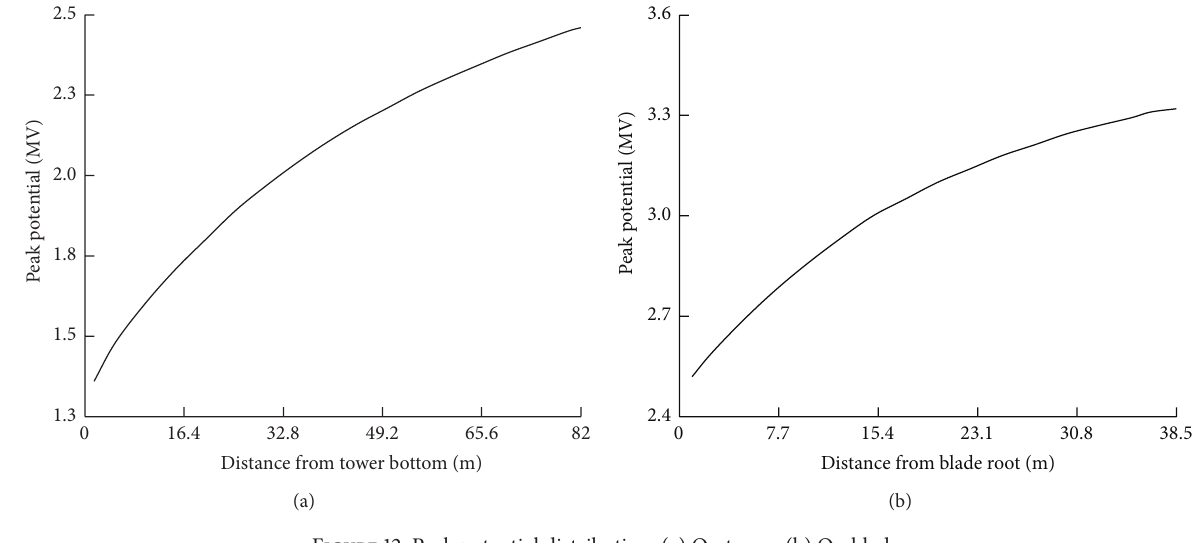
Figure 12: Peak potential distribution. (a) On tower. (b) On